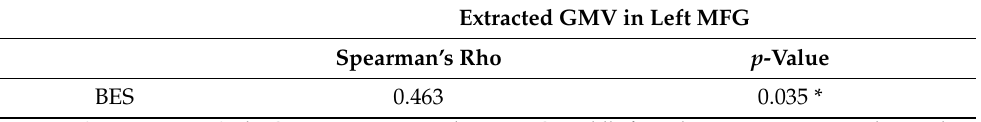
Table 4. BE group: correlation between BES scores and GMV in the left